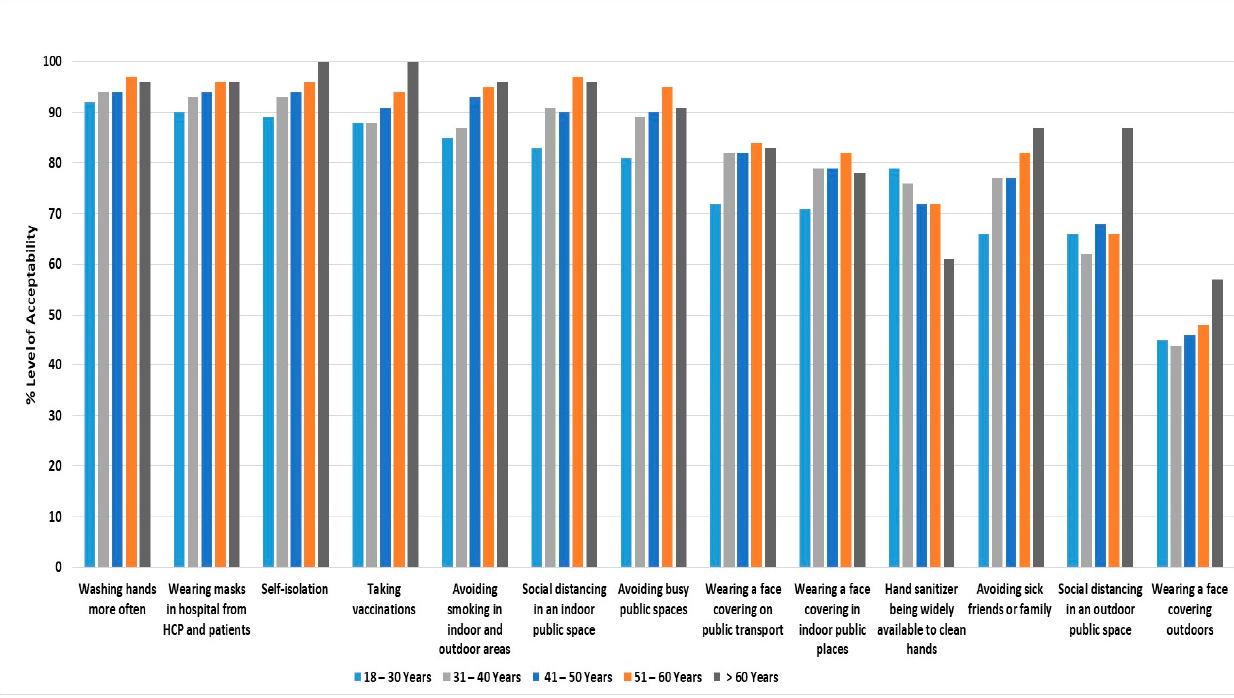
Figure 2. The acceptability of future policies for everyone at all times regarding respiratory virus infection control interventions by age.